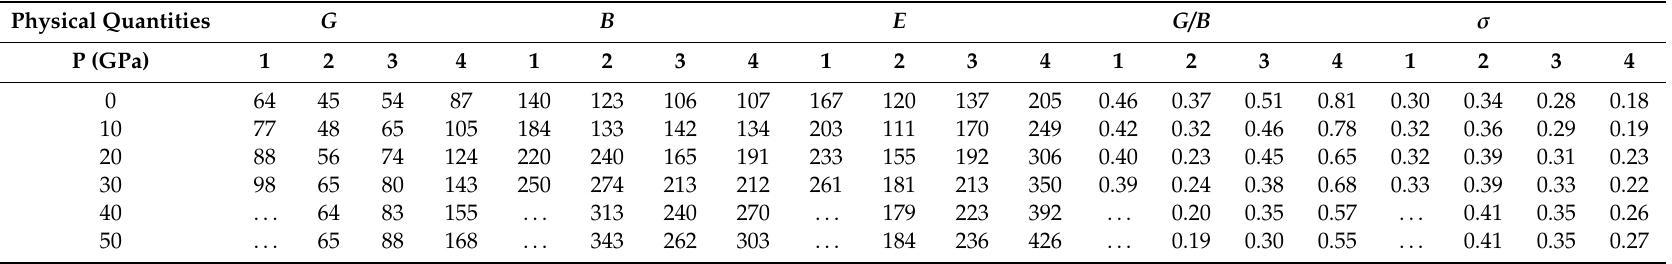
Table 1. The elastic constants C ij , the Shear modulus G (GPa), Bulk modulus B (GPa), Poisson’s ratio σ , Young’s modulus E (GPa), for (1) AlNiZr, (2) AlNi 2